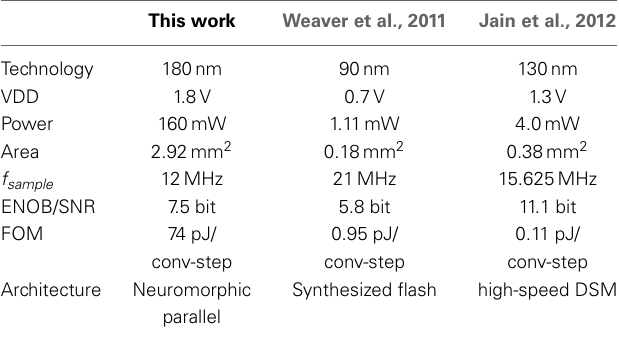
Table 7 | High sample rate, low resolution comparison.